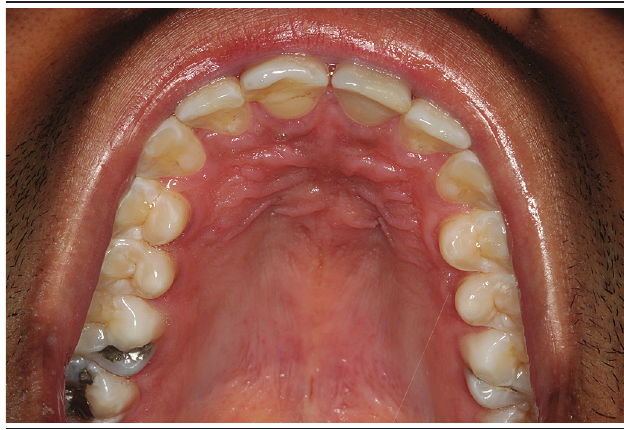
figurE 17 − Intraoral aspect of the patient of case 2, 30 months after surgery